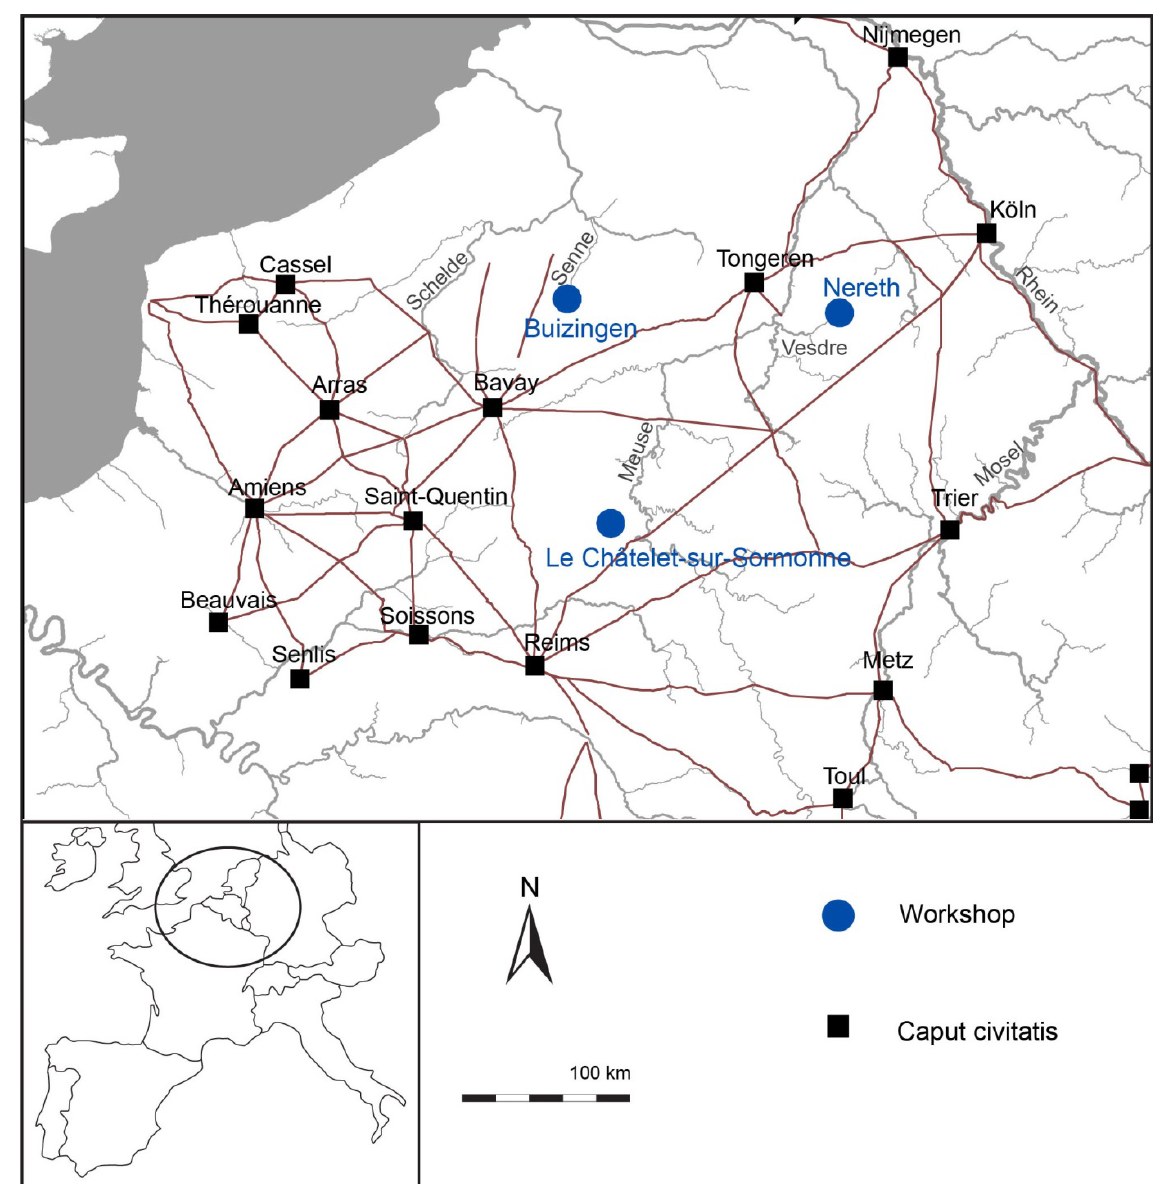
Figure 2: Location of the Gallo-Roman workshops of Le Châtelet-sur-Sormonne, Buizingen and Nereth and the main roads and civitates capitals in northern